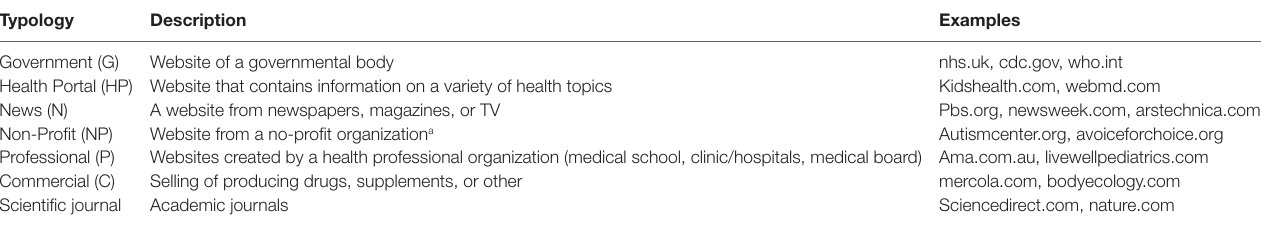
Table 1 | Definitions and examples of typology of websites.